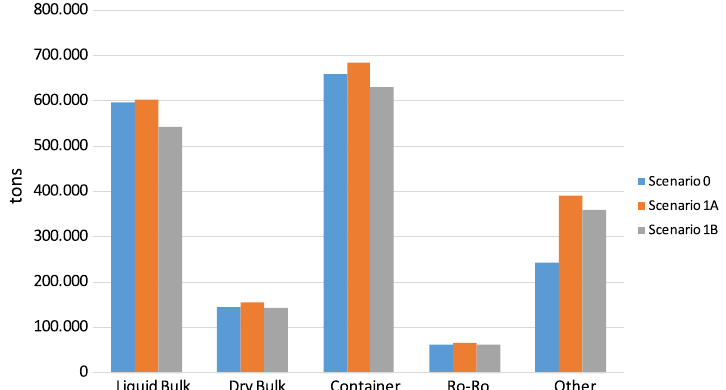
Fig. 7 Emissions of CO 2 in different